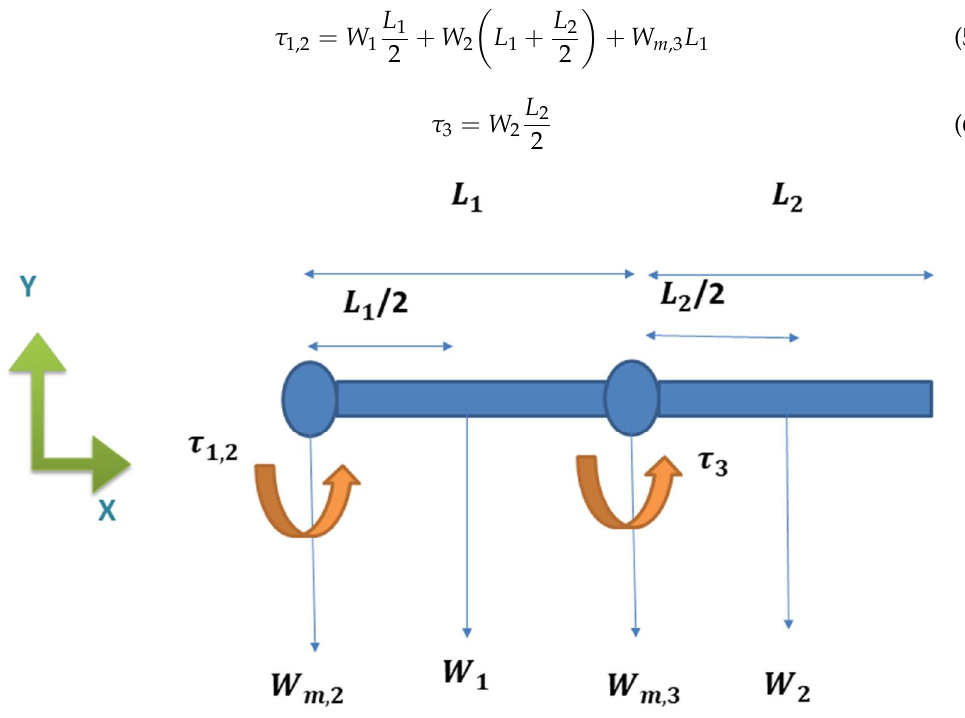
Figure 9. Free body diagram of SAMA exoskeleton arm.